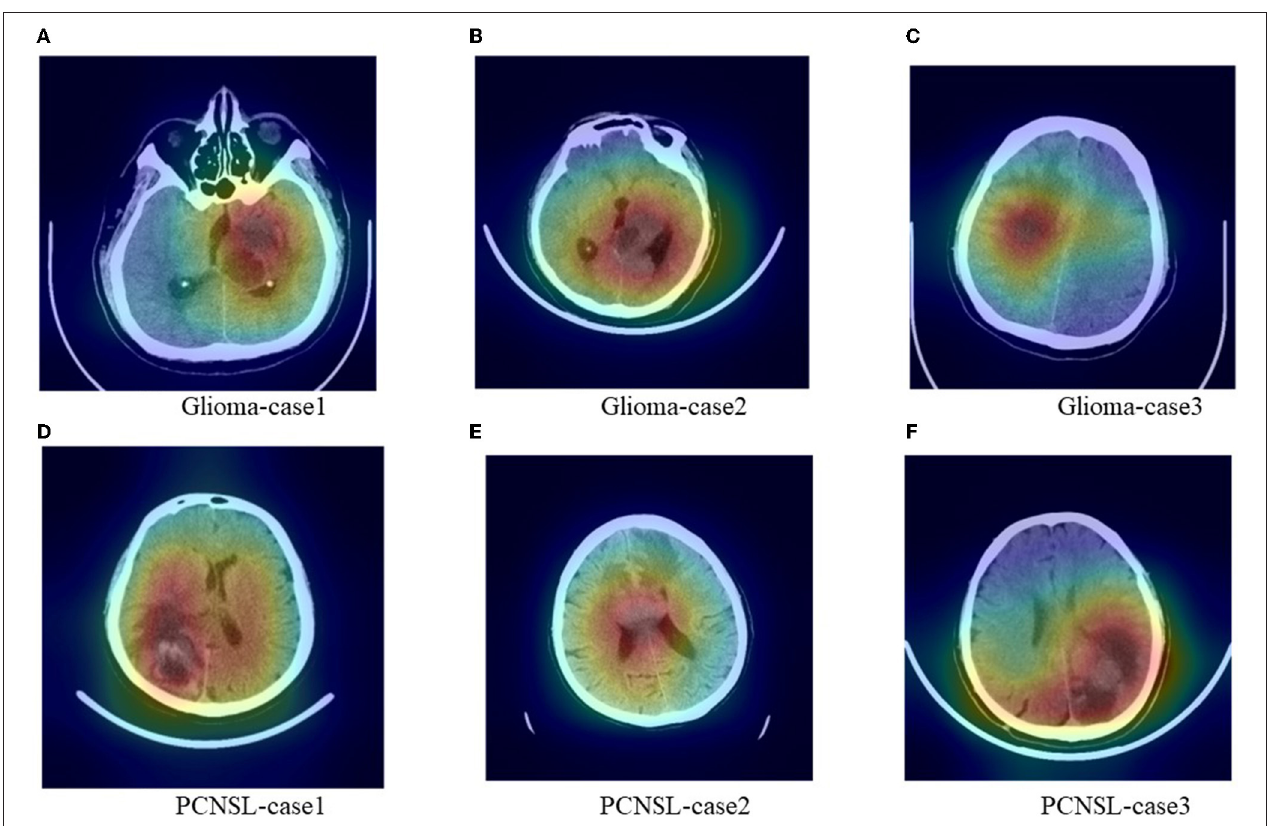
FIGURE 5 | Representative images with heatmaps from the CNN model using Grad-Cam ++ methods. The red regions were important for the diagnosis decision and the deep red regions overlapped with the tumor area. (A–C) were cases for glioma and (D–F) were cases for